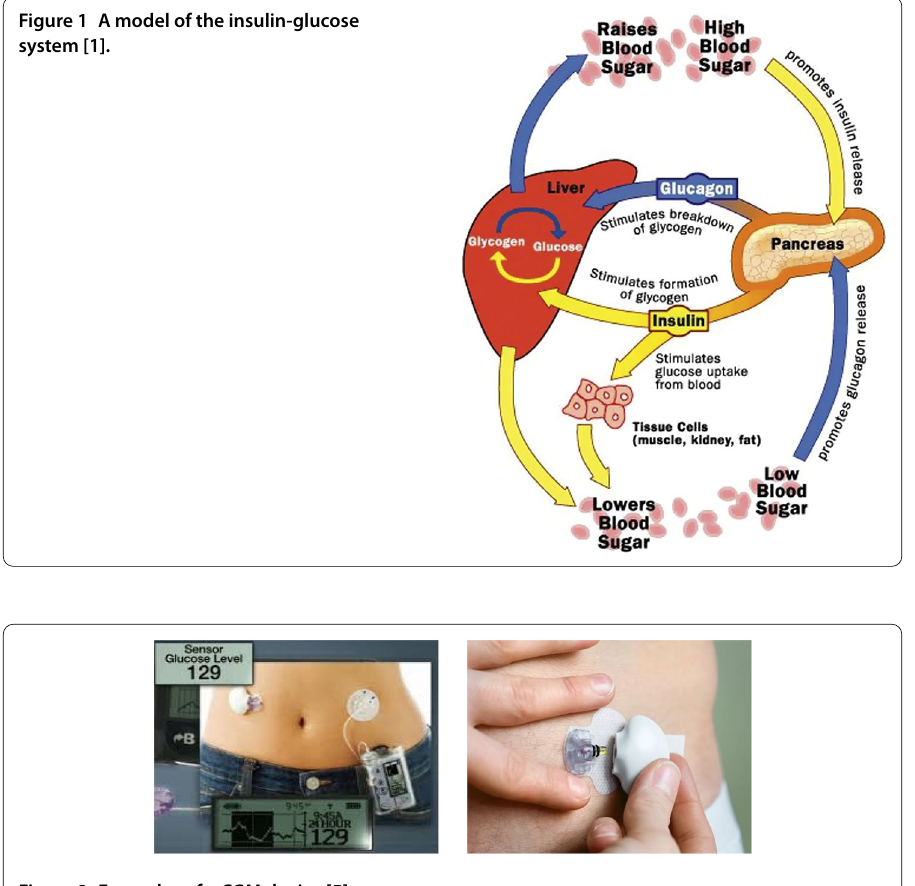
Figure 2 Examples of a CGM device